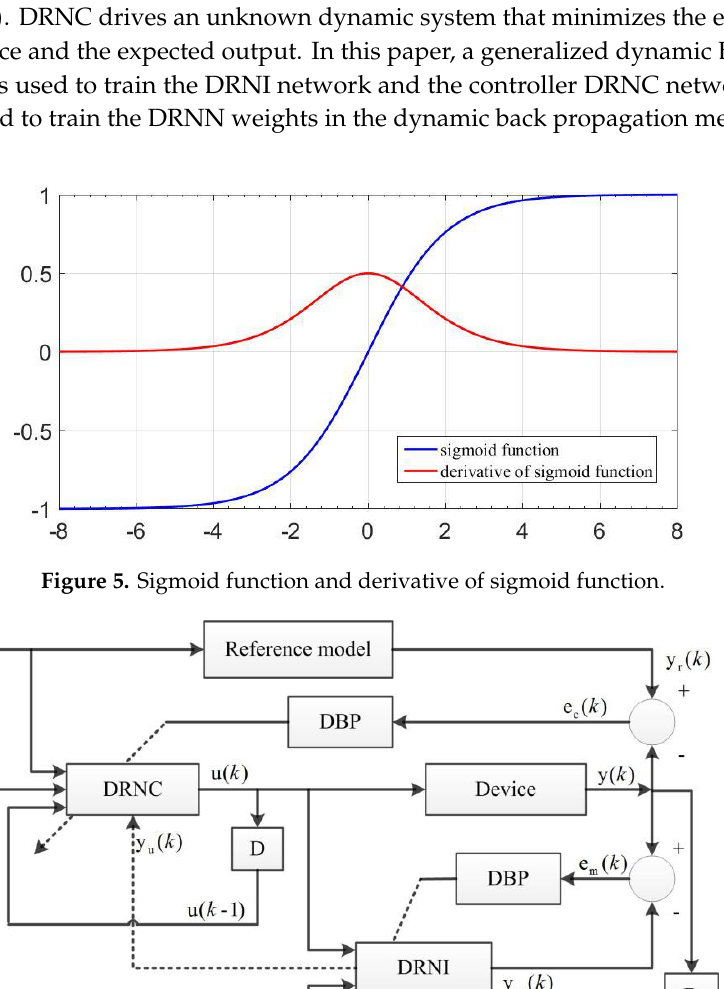
Figure 5. Sigmoid function and derivative of sigmoid function.